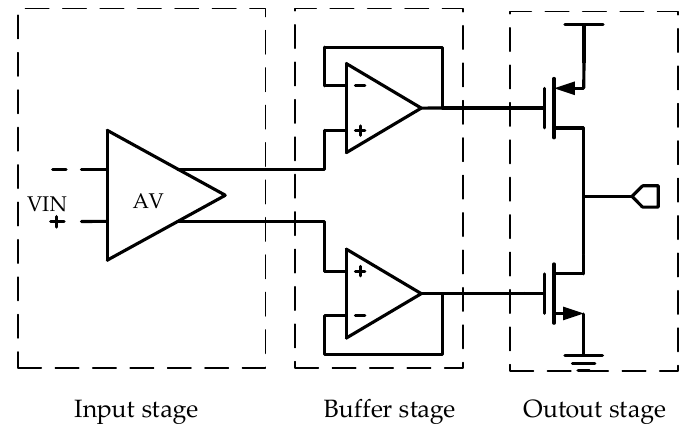
Figure 3. Simplified schematic of the linear stage.